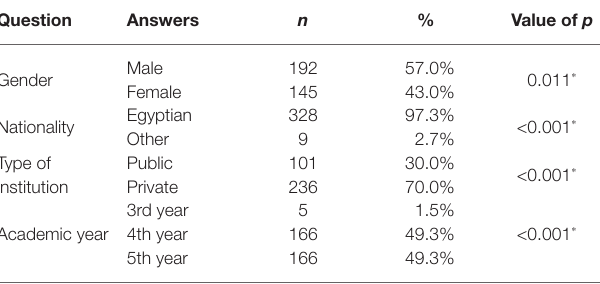
TABLE 1 | Frequency and percentage (%) for answers to demographic